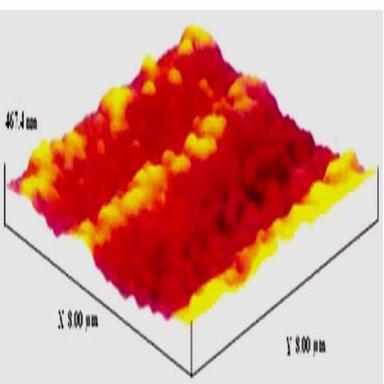
Atomic Force Microscopy of 3-dimensional assembly of Cu-Se grown electrochemically the usage of Ion Transfer Filters of Makrofol-KG.